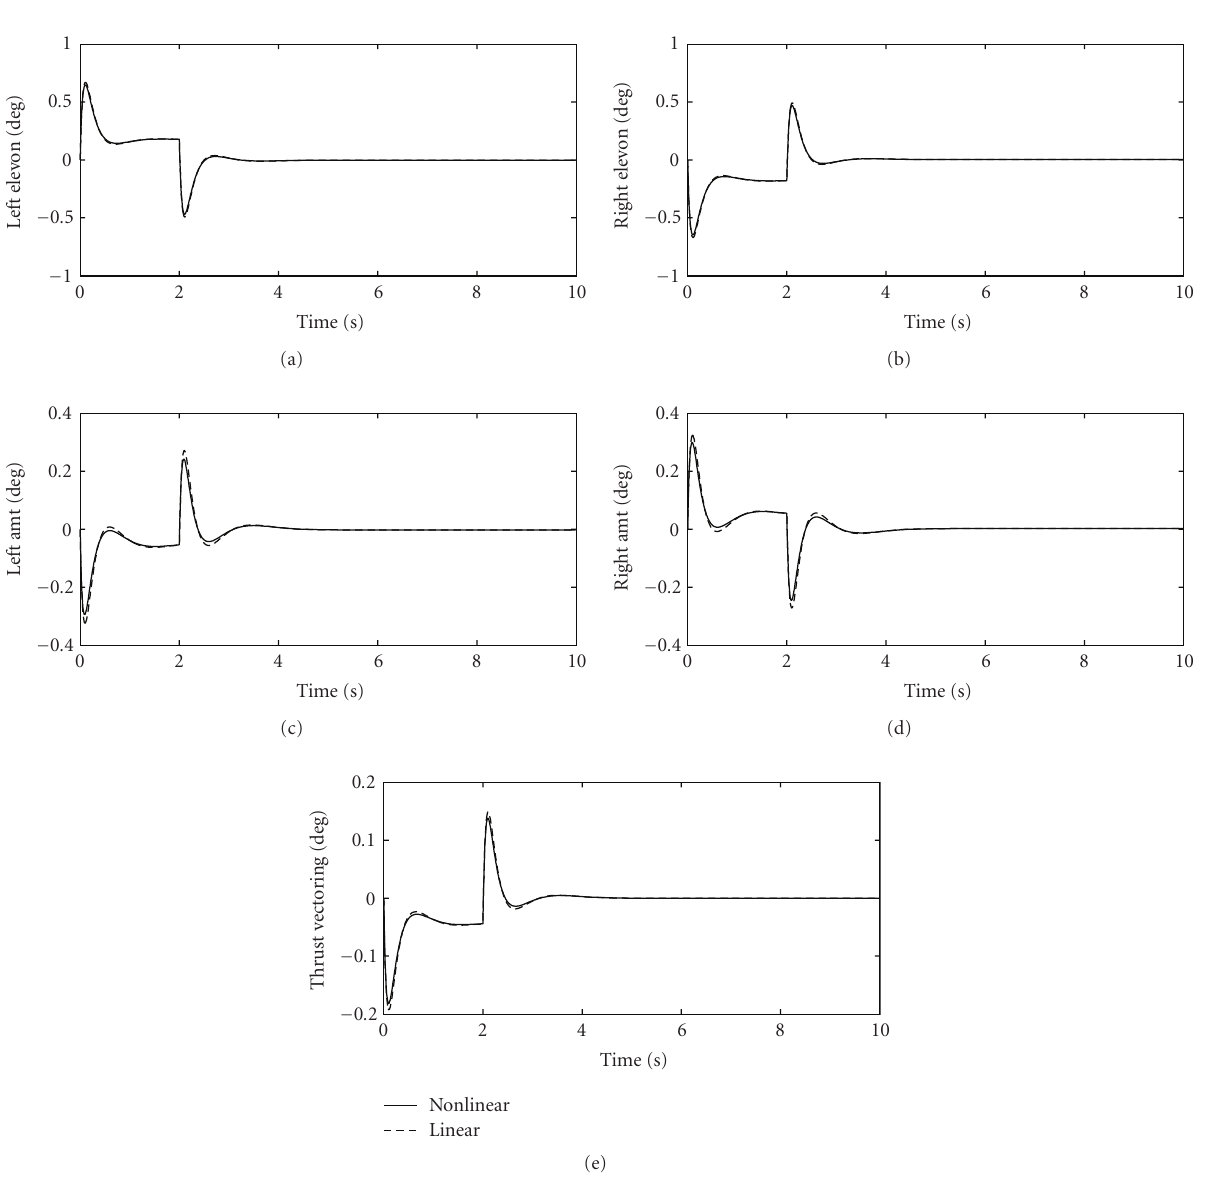
Figure 9: Nonlinear control responses to a 1deg/s p s